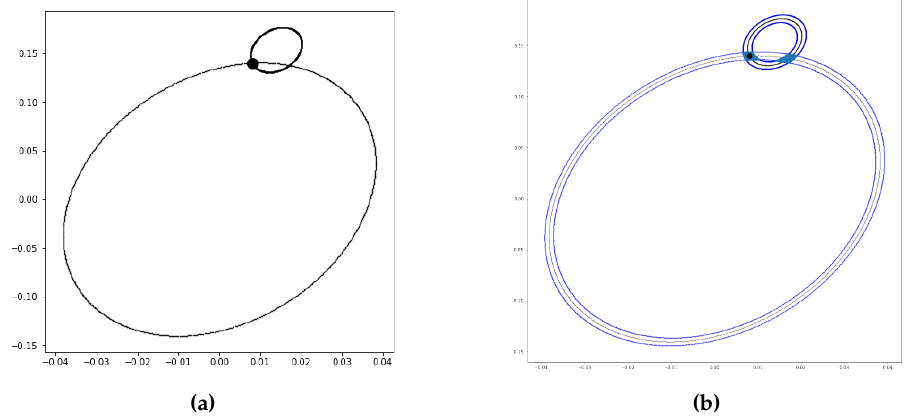
Figure 5. Examples of the exact and approximated conditions on a test with n a = 2. In the left equation the two black ellipsoids are the two constraints of the right system of (14), while in the right figure the two couples of concentric ellipsoids are the borders of the thick ellipsoids defined by (16) and the blue region Z r is the intersection of (18) and (19). The black dot in both the figures is the true solution. i ( a ): Exact conditions on N f and T f ; ( b ): Approximated conditions on N f and T f